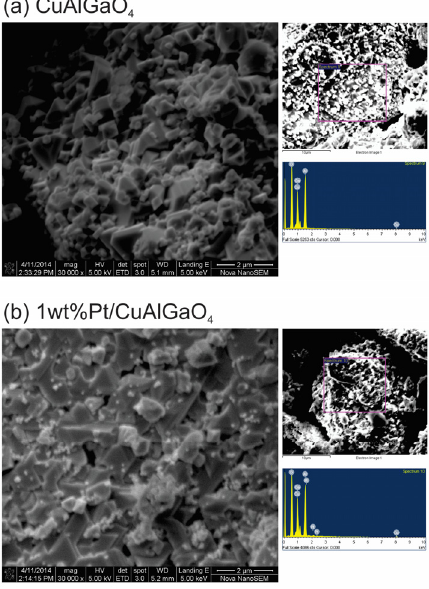
Figure 3. Scanning electron microscopy (SEM) images with corresponded elemental spectra of ( a )